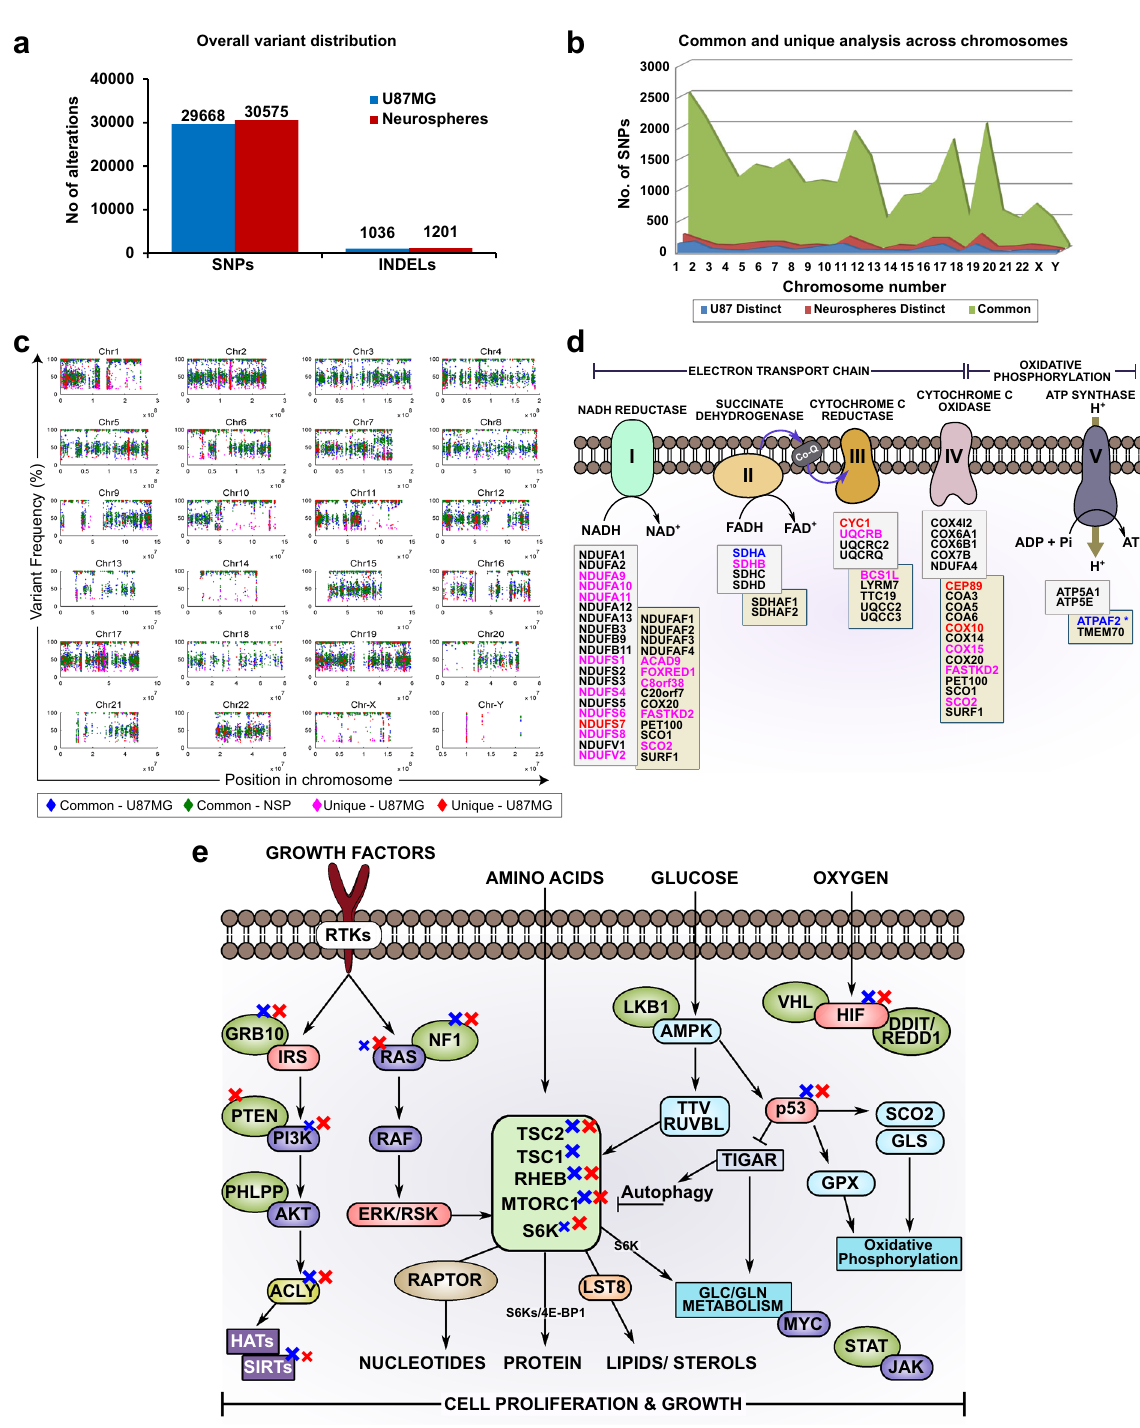
Fig. 2 Exome characterization of U87MG and NSP. a Variant distributions in U87MG and NSP. b SNPs that are common and unique across the TMZ sensitive (U87MG) and resistant (NSP) cells. c Chromosome-wide distribution of mutations. d Electron transport chain complexes and their associated mutations pro fi led using exome sequencing — blue fonts indicate mutations in U87MG, red fonts indicate mutations in NSP and pink fonts indicate mutations in both cell types. e Signaling network perturbations that play a key role in controlling metabolism. A blue cross indicates a mutation in U87MG, A red cross indicates mutation in NSP, size of the cross is scaled based on the number of mutations (either equal sizes or pro fi le obtained using microarray phenotyping for D-actinomycin There is a mutation in Cytochrome C-1 (Cyc1 gene) one of the (Supplementary Fig. 19). Due to its localization on the trans-inner- 11 genes in the mitochondrial respiratory chain (MRC) complex III membrane, a mutation can disrupt the Q-cycle mechanism and (Supplementary File 3). The unique mutation in the Cyc1 gene in coupling associated with electron transfer from ubiquinol NSP has an impact on respiration as seen in the cellular reductase